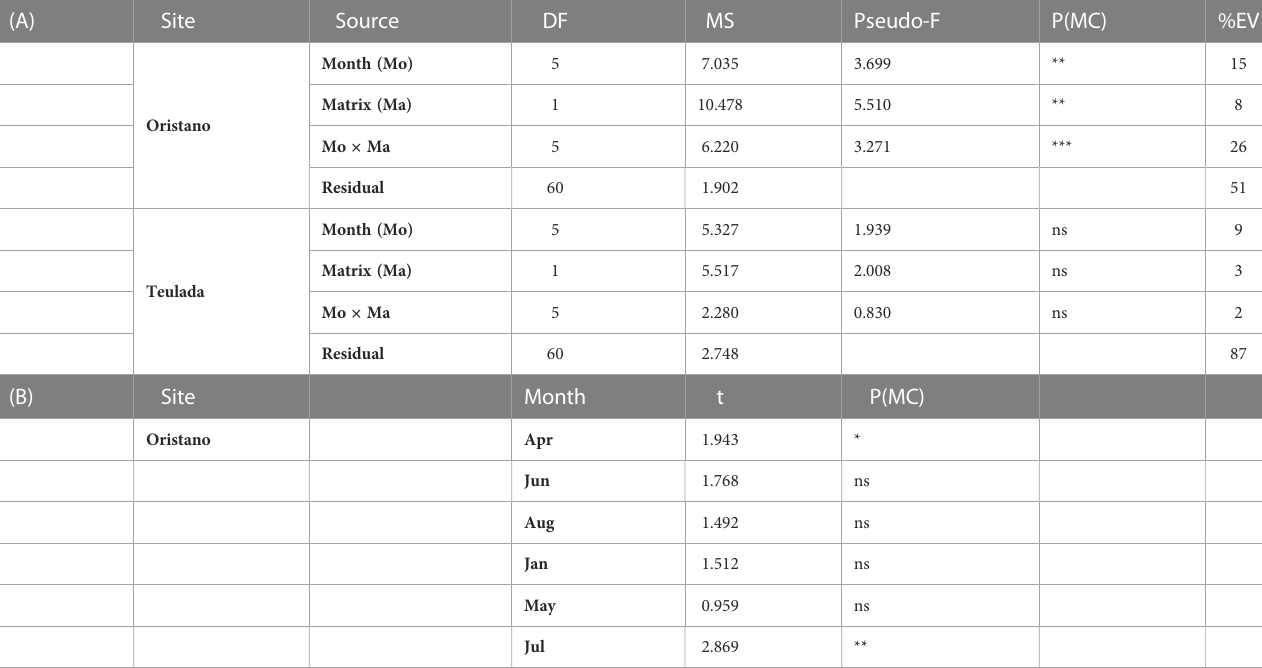
TABLE 3 Results of multivariate PERMANOVA testing for the effects of Month, Matrices and their interactions on the biochemical composition of OM in two study sites (A); and results of the pairwise comparisons testing for differences in the biochemical composition of OM between sediment and feces in the meso-eutrophic site (Oristano) during the study period